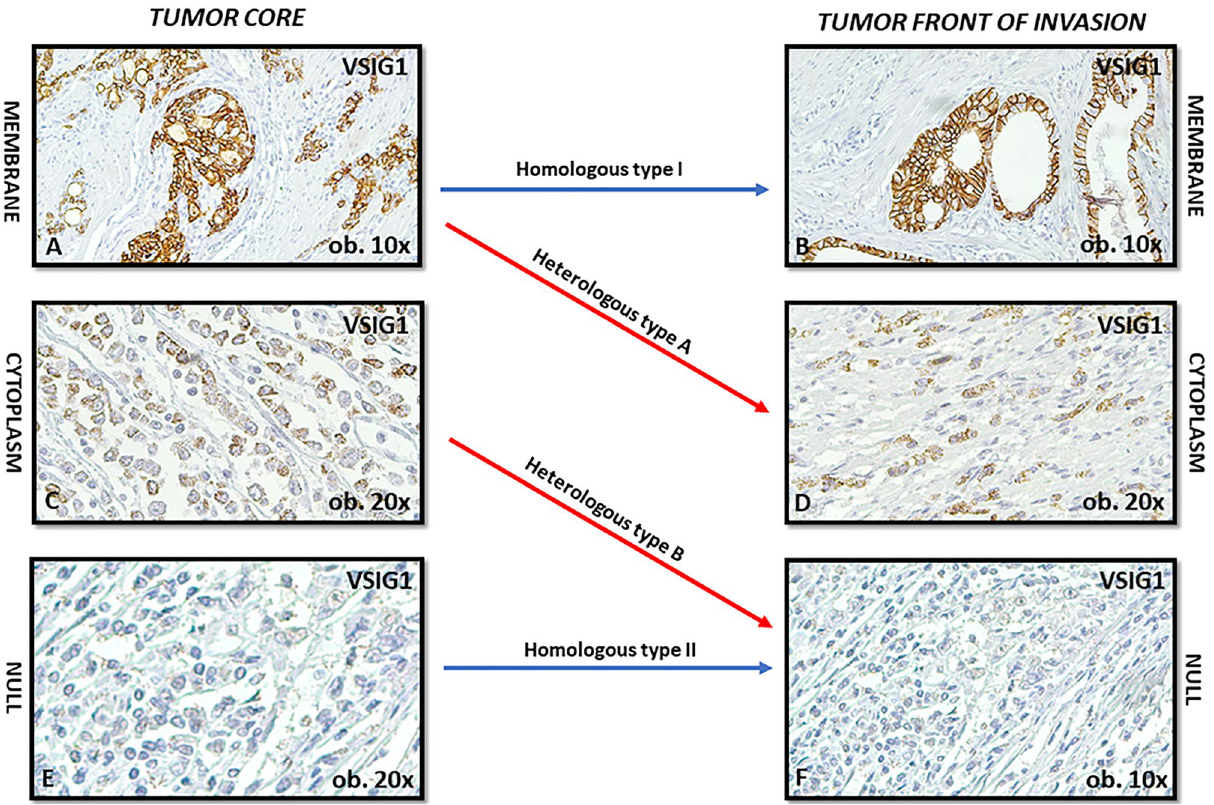
Figure 1. VSIG1 can exhibit three patterns of expression in tumor core versus front of invasion: homologous membrane-membrane (type I), homologous null-null (type II) and heterologous immunostaining (type A: membrane/cytoplasm and type B: cytoplasm in core/null in the invasive